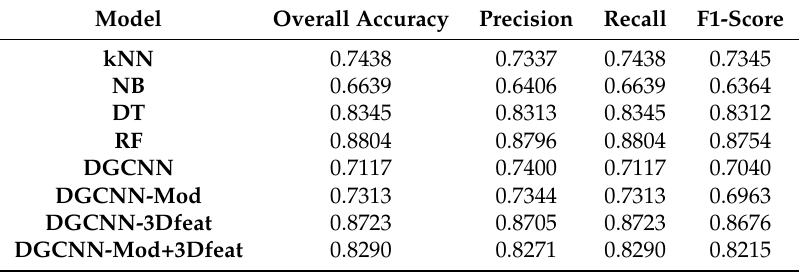
Table 2. Weighted metrics computed for the Test set of the Trompone scene divided into 3 parts: Training, Validation,